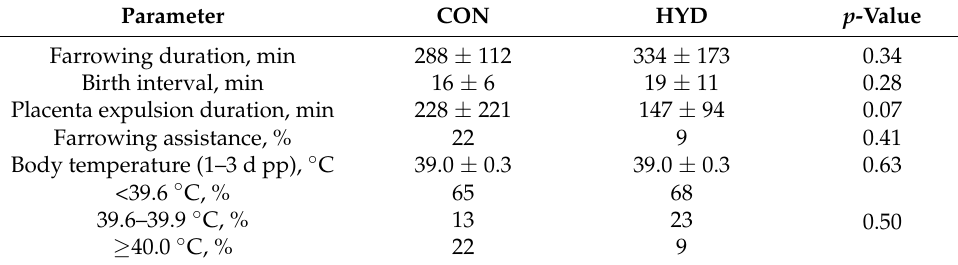
Table 8. Effect of dietary vitamin D source on birth parameters (mean ±